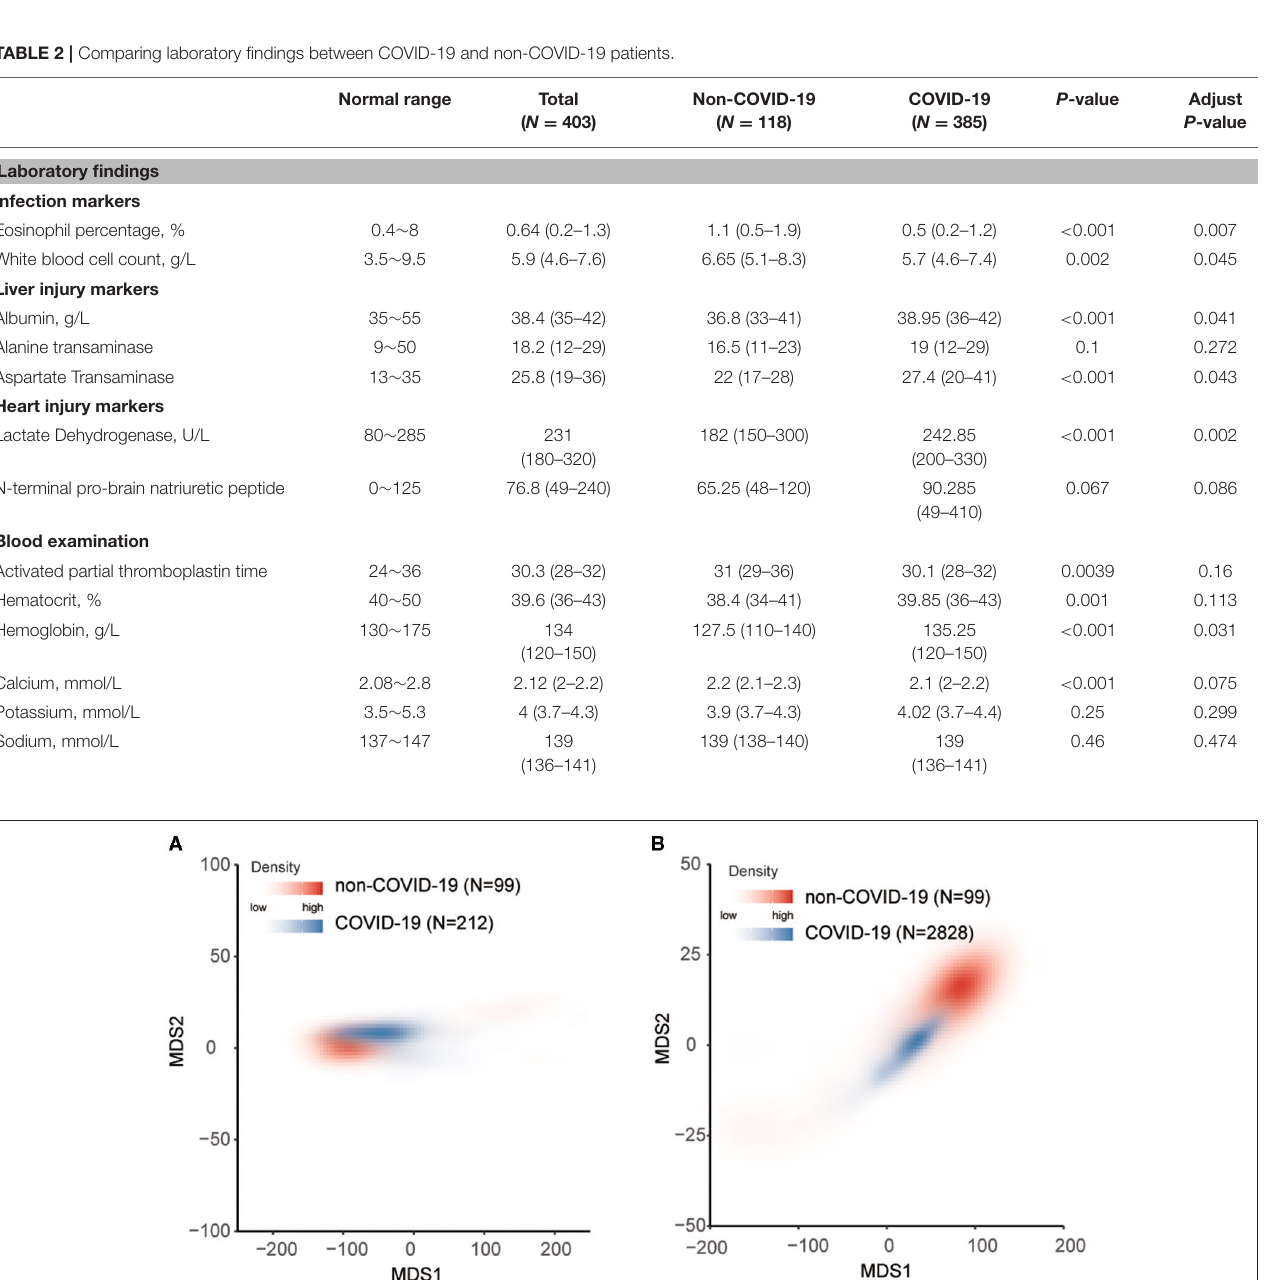
FIGURE 5 | MDS plot for distinguishing non-COVID-19 from COVID-19 based on laboratory findings. Red represents non-COVID-19 and blue represents COVID-19. The depth of the color represents the density. (A) The difference between FPHJ-548 and nCVP-118 dataset. (B) The difference between nCVP-118 and the HSSH-3015